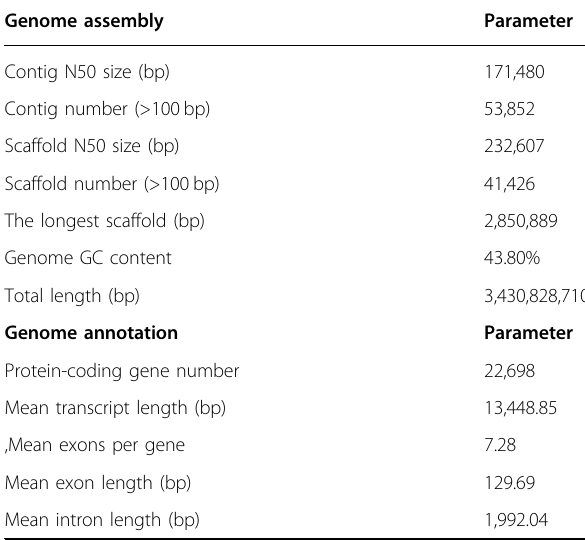
Table 1 Statistics of the genome assembly of C. betulinus